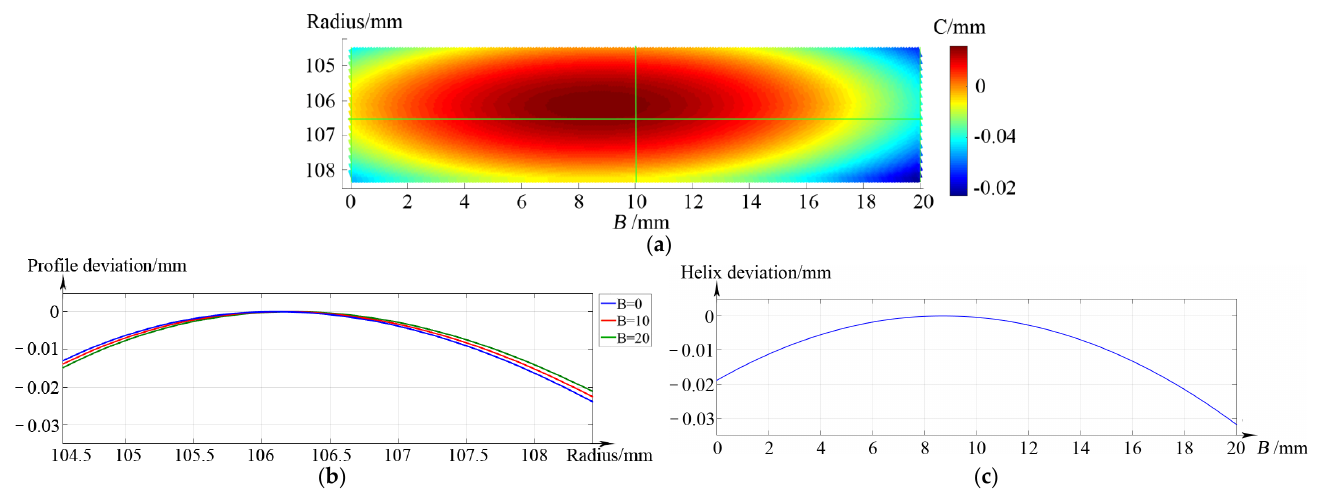
Figure 5. Calculated deviations of the gear tooth flank enveloped via alterable shaft angle skiving method. ( a ) deviation contour plot, ( b ) profile deviation, ( c ) helix deviation.